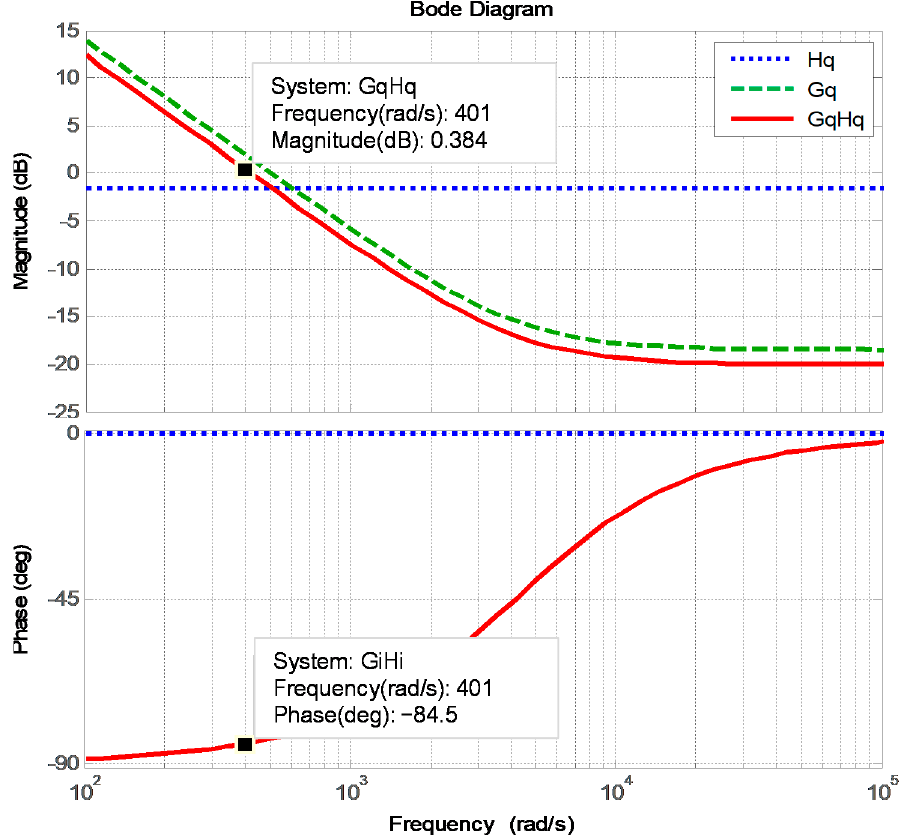
Figure 11. Bode plot of the reactive power control loop. The RBFNN controller added in the reactive power controller loop is as shown in Figure 12. The RBFNN is a feedforward NN using Gaussian activation functions, and the weights of the RBFNN are determined adaptively. The RBFNN offers advantages such as structural and computational simplicity, high noise immunity, avoidance of local minima,